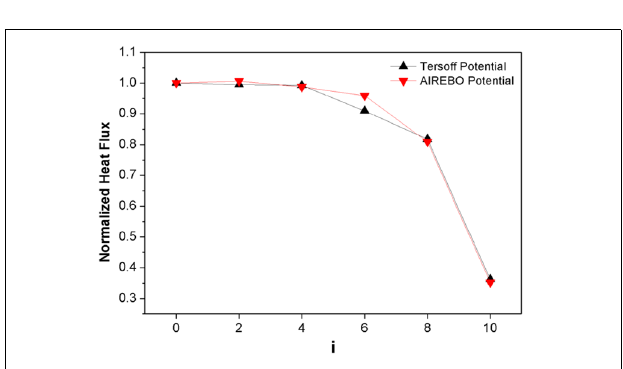
FIGURE 2 | Local heat flux distribution in the cross section of 21-GNR. The local heat flux along the center of GNR is used as reference.